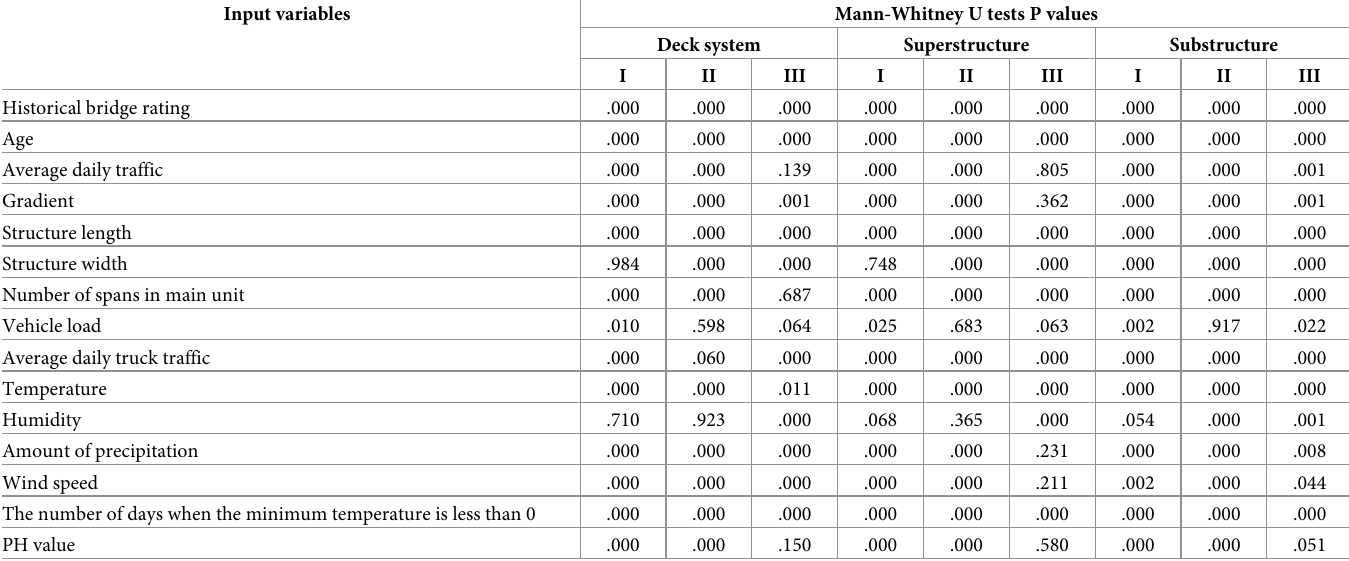
Table 7. Summary of P values from the Mann-Whitney U test. Input